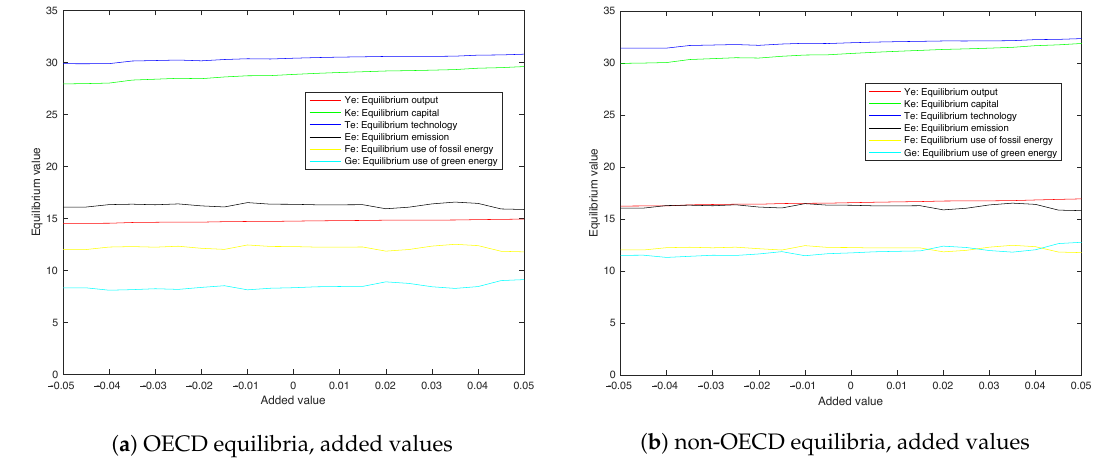
Figure 18. Equilibrium values, added values.